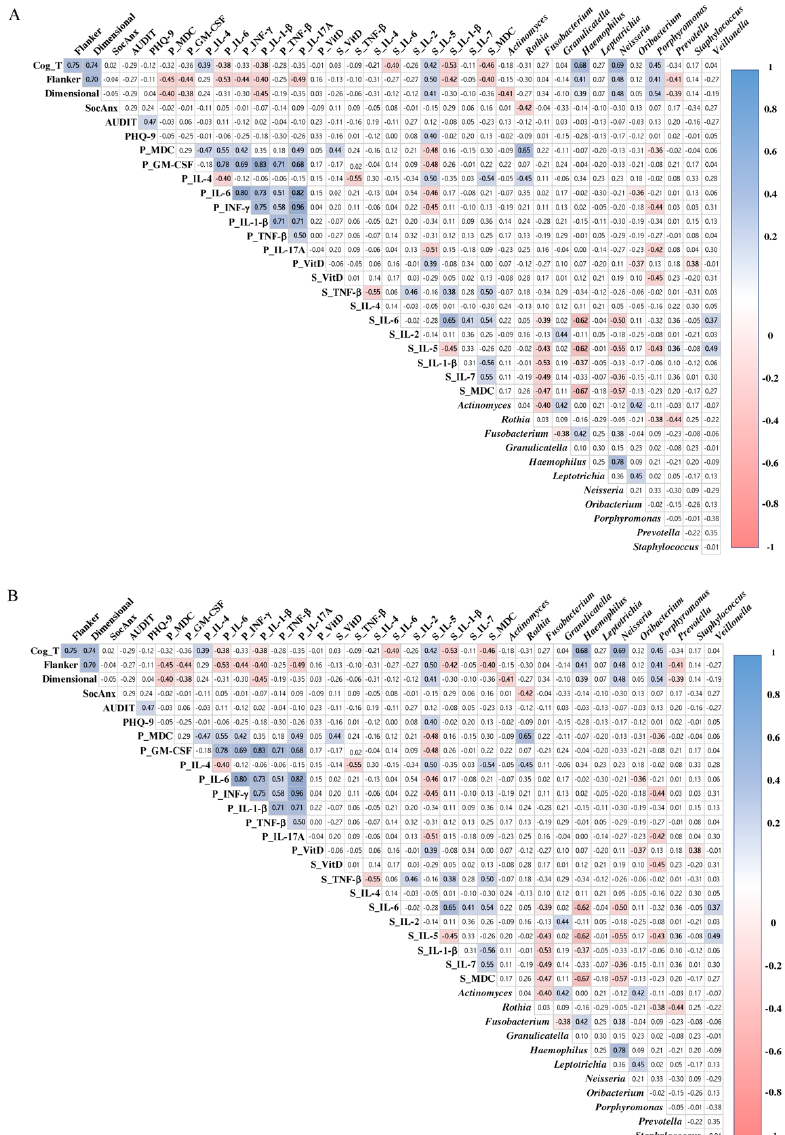
Figure 8. Spearman Rho correlation among depression, social anxiety, executive functions, microbiota, and inflammatory markers in alcohol group ( A ), and control group ( B ). White squares indicate no significant association; blue squares indicate significant positive association; red squares indicate significant negative associations. Color intensity reflects stronger associations as determine by the correlation coefficient value ( y -axis); p < 0.05. Cog_T: cognitive composite score of the NIH toolbox cognition battery; Flanker: Flanker inhibitory control and attention test; Dimensional: dimensional change card sort test; SocAnx: scores in the Leibowitz Social Anxiety Scale; AUDIT_T: total score in the Alcohol Use Disorders Identification Test; PHQ9: scores in the nine-item Patient Health Questionnaire; P_MDC: levels of macrophage-derived chemokine in plasma; P_GM-CSF: levels of granulocyte-macrophage colony-stimulating factor in plasma; P_VITD: levels of vitamin D in plasma; S_VITD: levels of vitamin D in saliva; S_MDC: levels of macrophage-derived chemokine in saliva. Other cytokines / chemokines expressed in plasma and saliva are: P_IL-4, P_IL-6, P_INF- γ , P_IL-1 β , P_TNF- β , P_IL-17A, S_TNF- β , S_IL-6, S_IL-2, S_IL-5, S_IL-1 β , and S_IL-7. The following are bacteria found in saliva: Actinomyces , Rothia , Fusobacterium , Granulicatella , Haemophilus , Leptotrichia , Neisseria , Oribacterium , Porphyromonas , Prevotella , Staphylococcus , and Veillonella